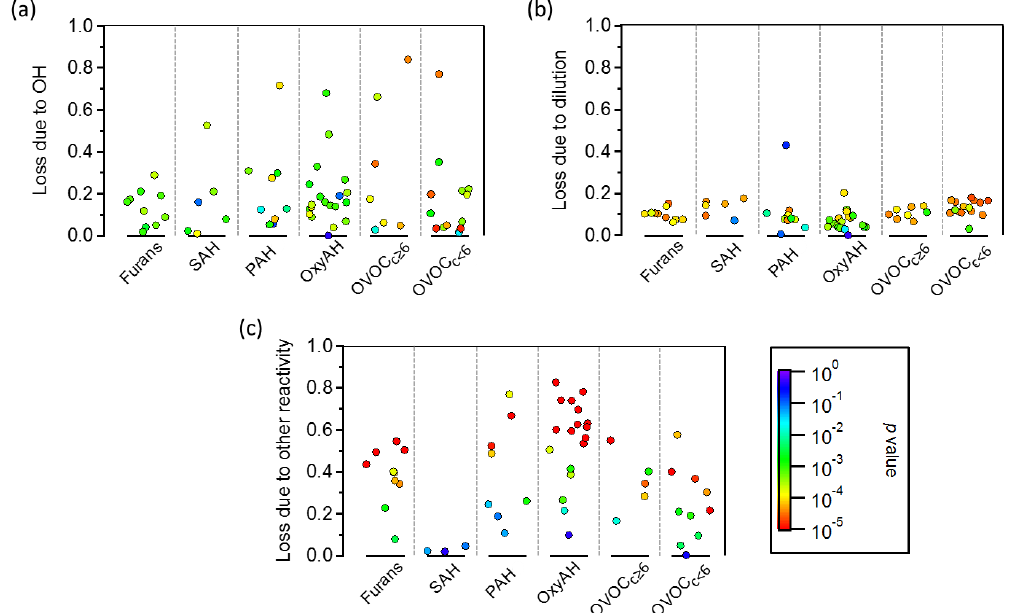
Figure 6. Fraction of consumed precursor compounds for Set 1 by OH oxidation (a) , dilution (b) and other reactivity (c) at the end of the experiments. Each point corresponds to a single compound averaged among experiments and normalized to the initial concentration. The colour legend represents the statistically significant deviation from zero reactivity with the investigated reactant ( p